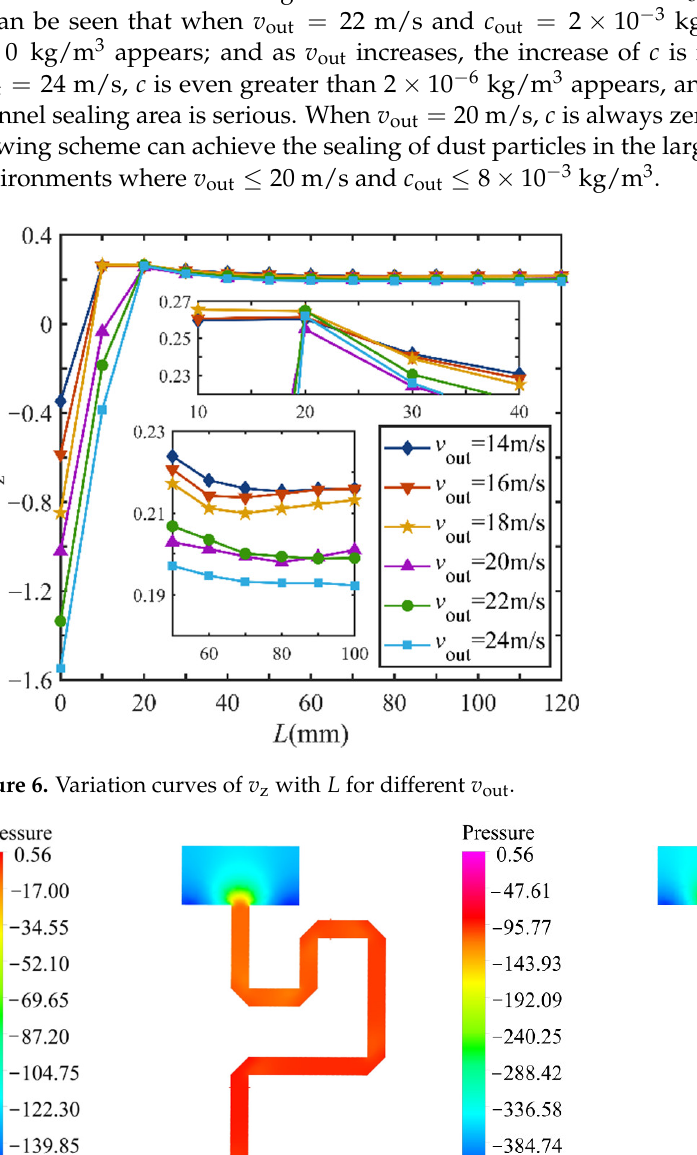
Figure 7. Pressure distribution at the x = 0 mm section position of the large-aperture channel at different v out . ( a ) v out = 14 m/s; ( b ) v out = 24 m/s.